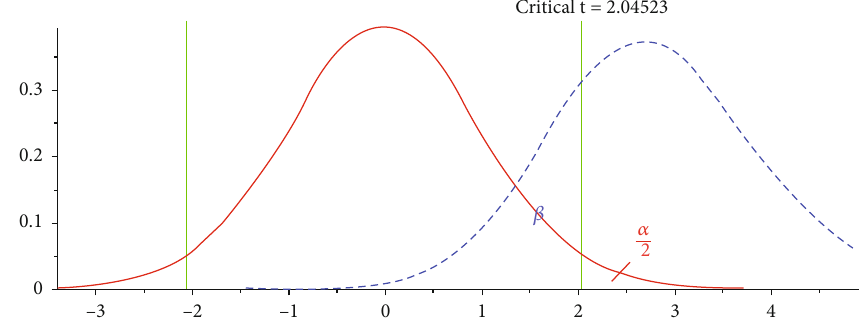
Figure 1: Schematic diagram of the sampling